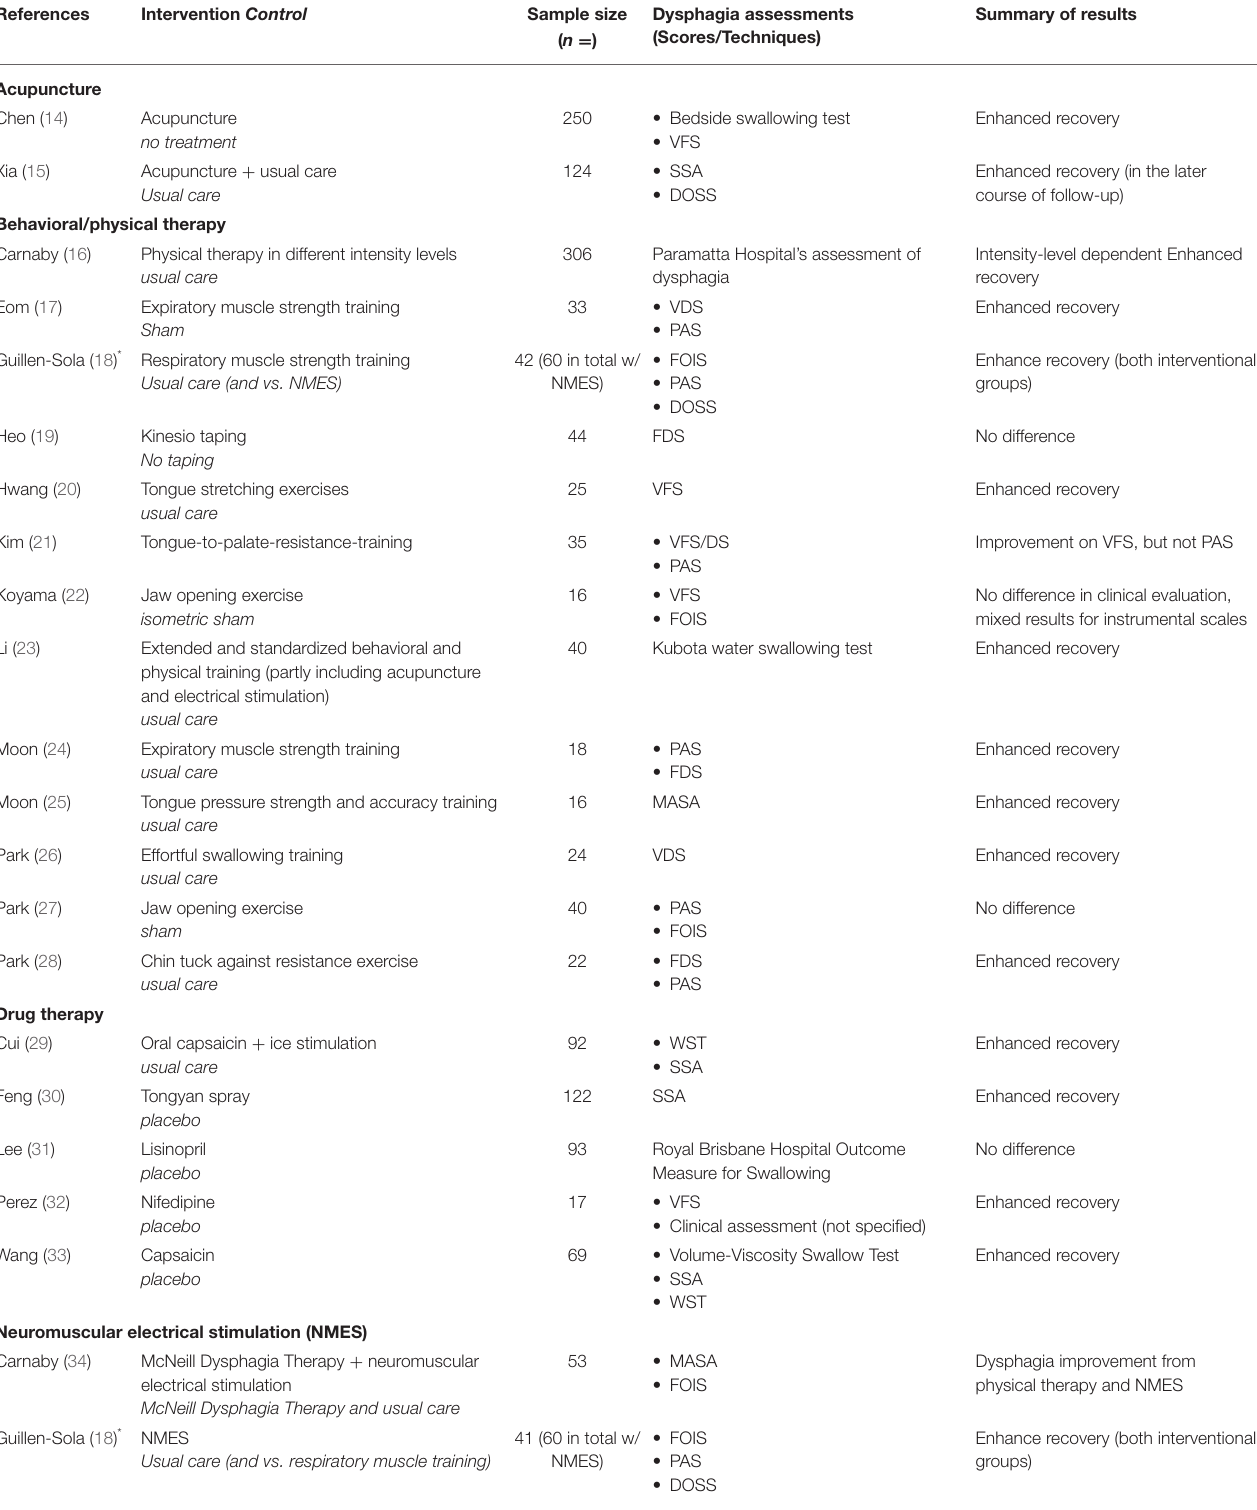
TABLE 1 | Summary of